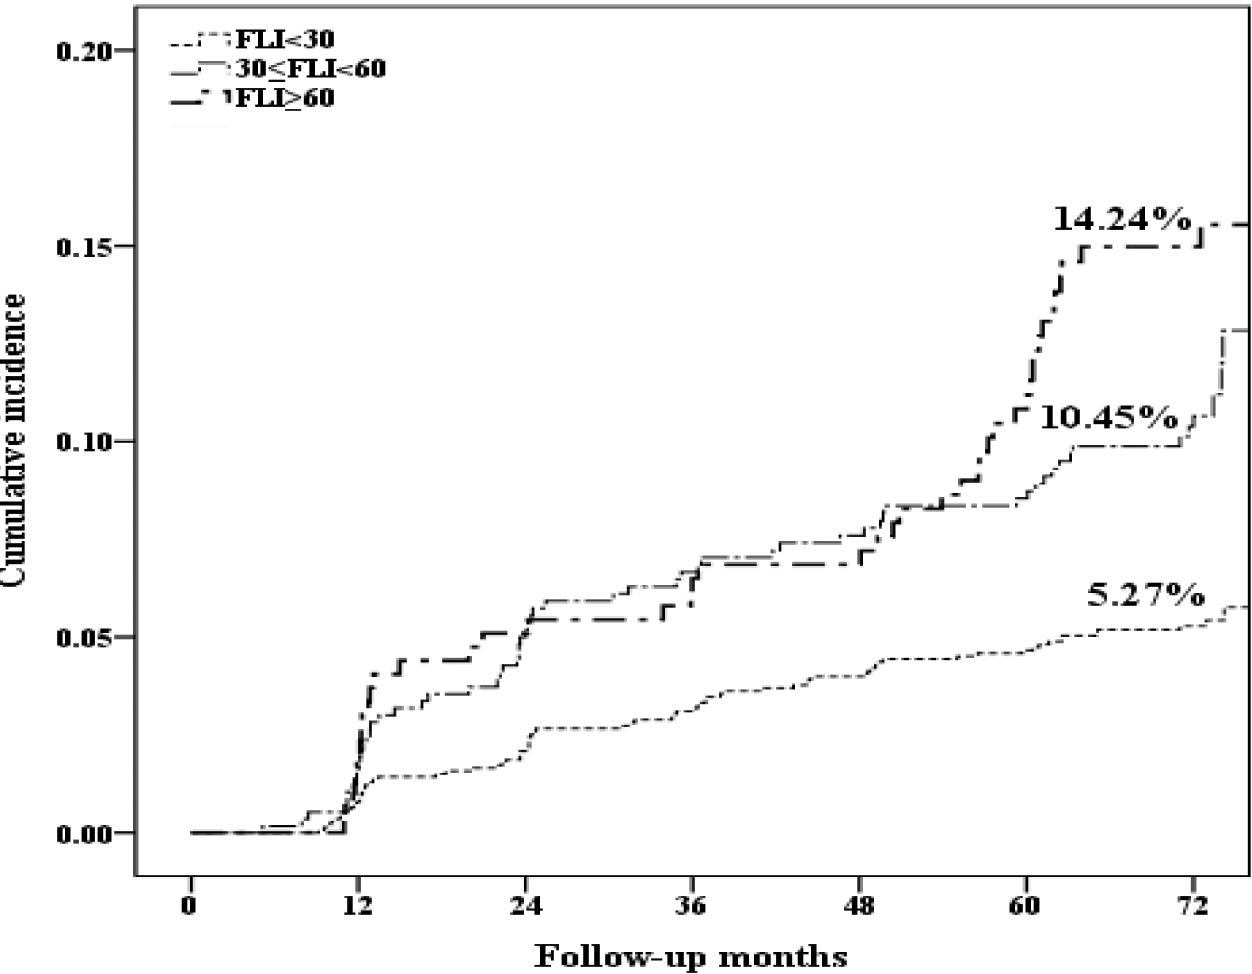
Fig 2. The cumulative incident asymptomatic IVBS in three groups. The results of Kaplan–Meier analysisshowed that there was a significantly higherincidenceof asymptomatic IVBS in participants with higher FLI comparedto those with FLI < 30 (P < 0.001 for both FLI < 30 vs 30 (cid:20) FLI < 60 and vs FLI (cid:21) 60, respectively).